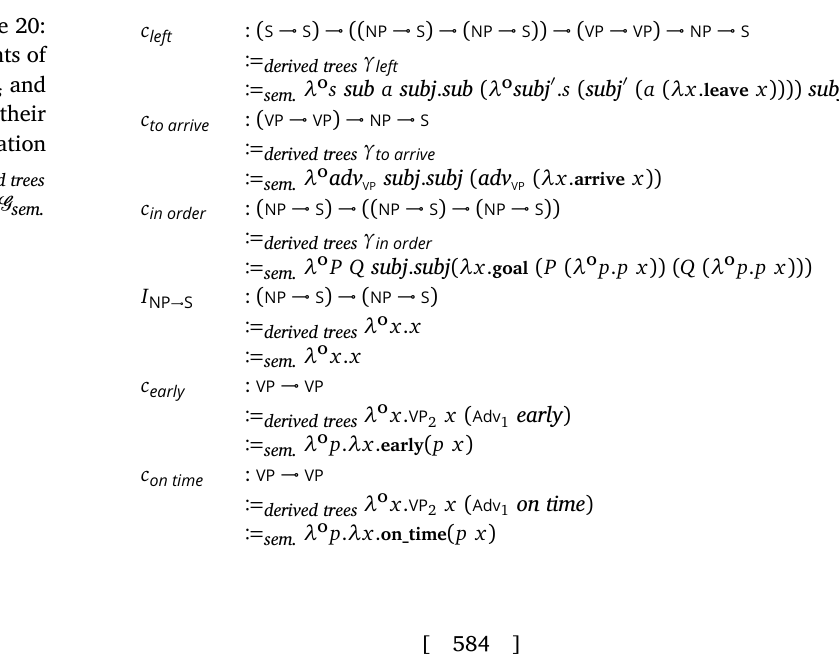
Constants of (cid:6) derivations and their interpretation by G derived trees and G